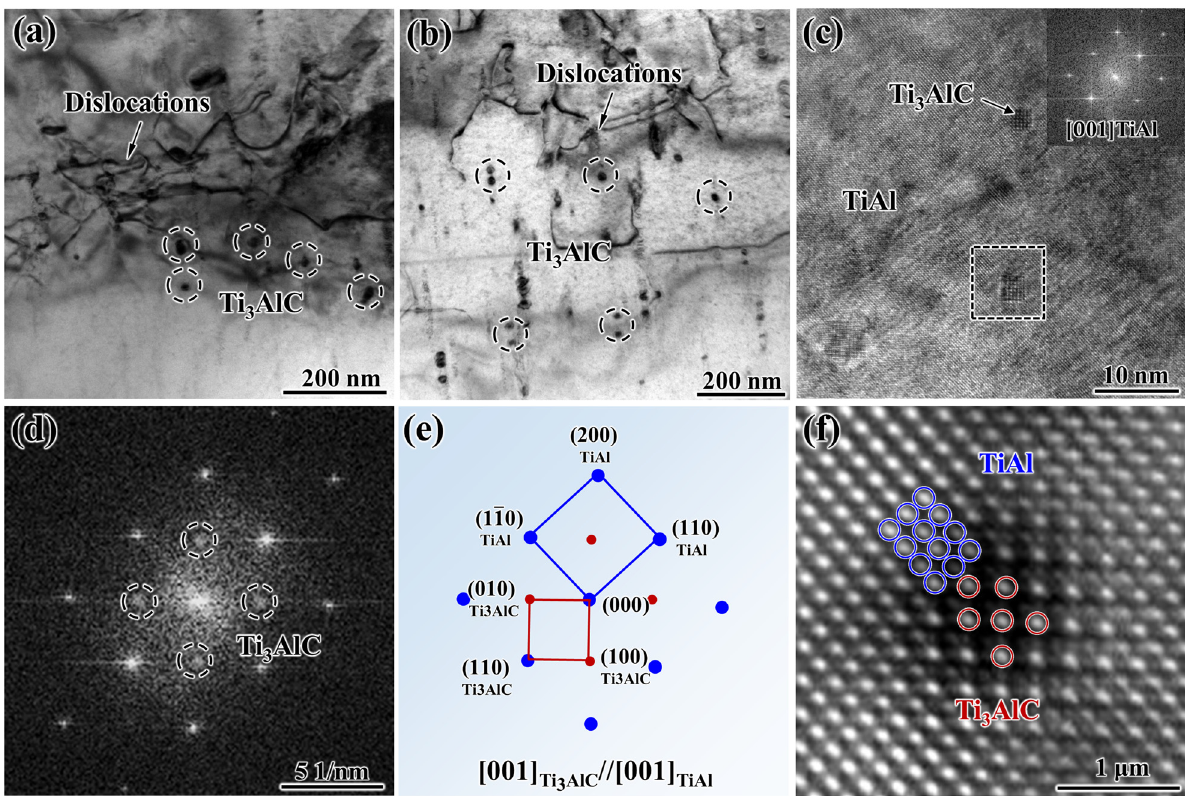
Figure 6: The TEM analysis of needle - like Ti 3 AlC nano - precipitates in TiAl alloys: ( a and b ) TEM images; ( c ) HRTEM image; ( d ) FFT pattern of the square area in ( c ) ; ( e ) indexing of the FFT pattern in ( d ) ; and ( f ) IFFT image of the square area in ( c )